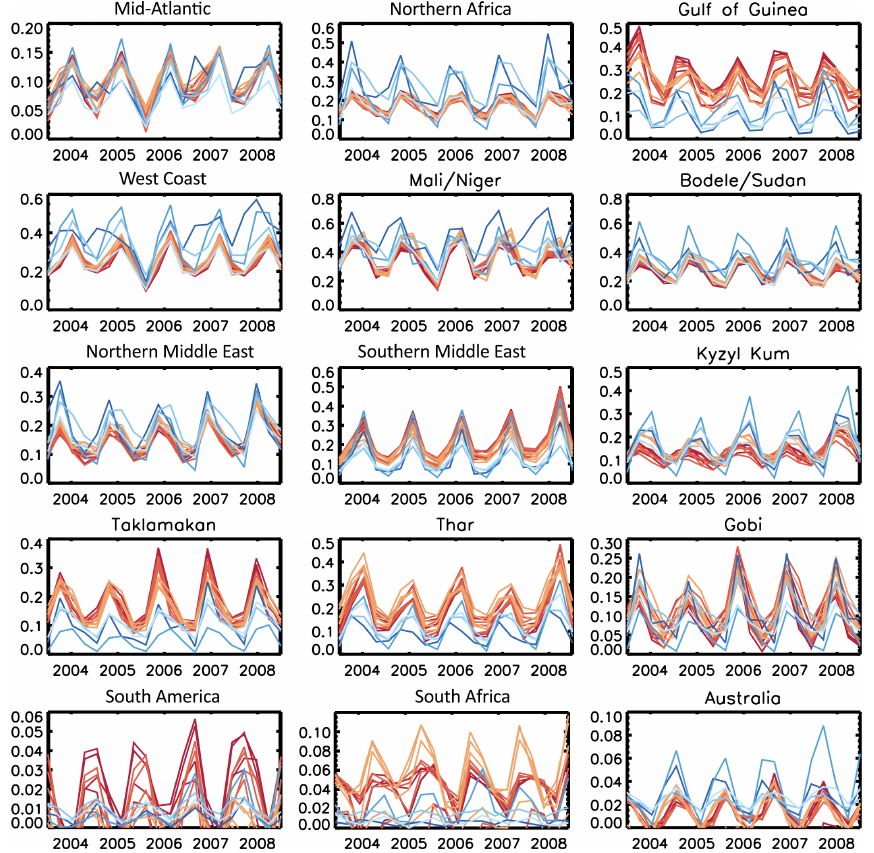
Figure 8. Same as Fig. 7a but for each individual region (in Fig. 1). Observational dust AOD is shown for multiple realizations of MODIS Aqua, MODIS Terra, and MISR (dark to light red). Models are GEOS-Chem, CESM, WRF-Chem, and MERRAero (dark to light